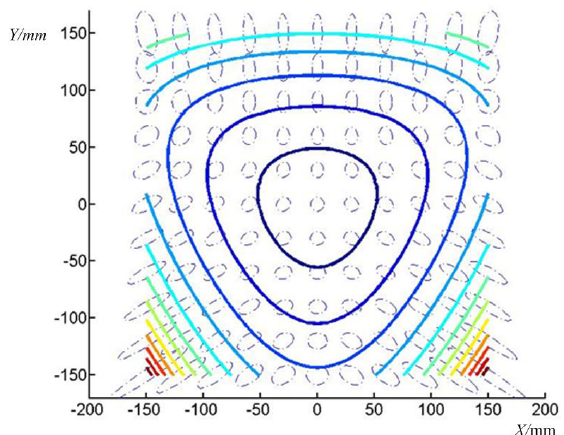
Figure 16. Responses of the displacements of the platform in case 2.